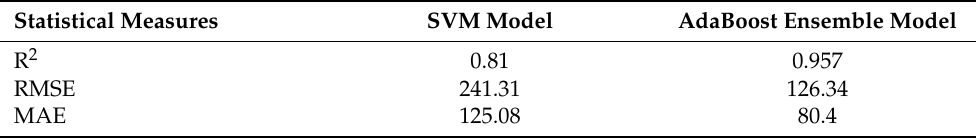
Table 3. SVM model statistical measures to depict its significance.